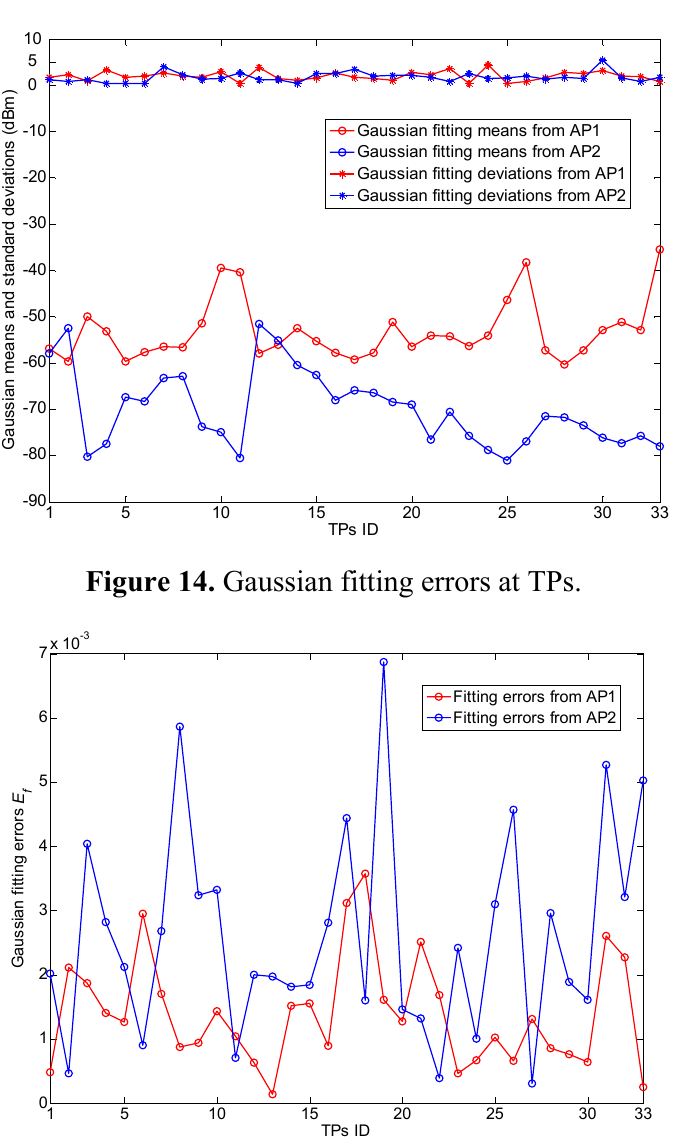
Figure 13. Optimal means and standard deviations in Gaussian fitting models at TPs.